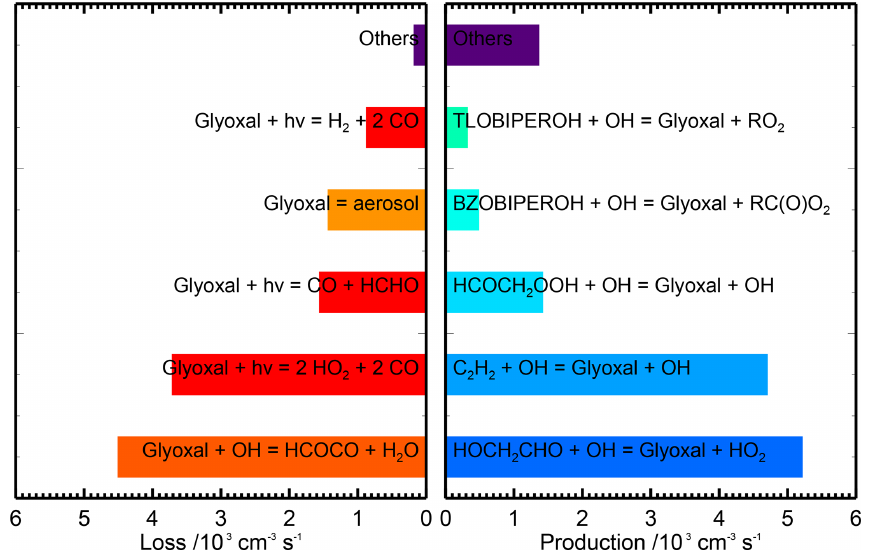
Figure 11. Midday (11:00–13:00) average glyoxal budgets for the base model run for both measurement periods combined. Chemical names are as given by the MCM. Note that there are three photolysis channels contributing to the loss of glyoxal which are shown separately but constitute the dominant loss process overall. For information on molecular formulae and details of production mechanisms of BZOBIPEROH and TLOBIPEROH, please see http://mcm.york.ac.uk/roots.htt#aromatics (last access: 12 April